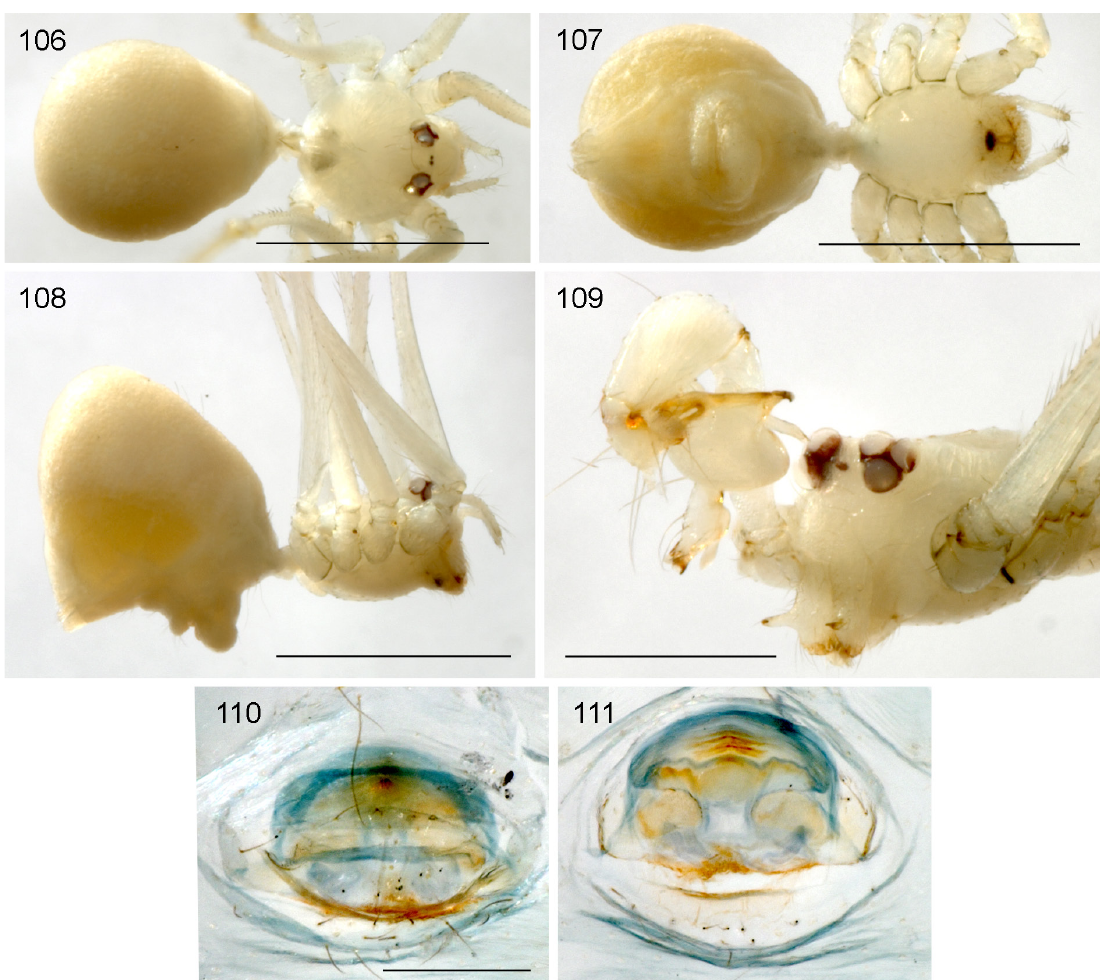
Figs 106-111. Quamtana kitahurira Huber, 2003. 106-108 . ♀, dorsal, ventral, and lateral views. 109 . ♂ prosoma, oblique frontal view. 110-111 . Cleared ♀ genitalia, ventral and dorsal views. Scale lines: 106-108 = 1 mm; 109 = 0.5 mm; 110-111 = 0.2 mm.